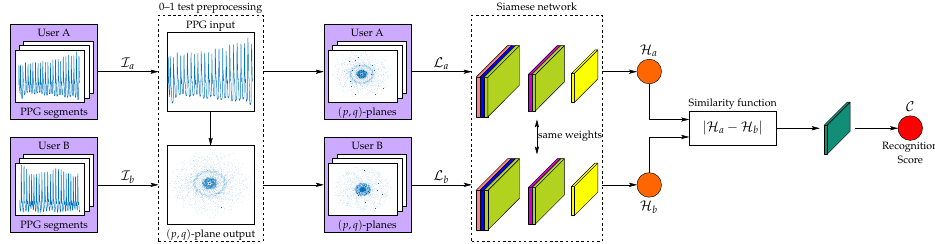
Figure 2. System architecture schematic overview (a zoomed view is shown in Appendix A). The branch of Siamese network architecture is an Inception-ResNet-V1 [59] due to its recognized capacity as a classifier and its characteristics compared to its previous versions and competing